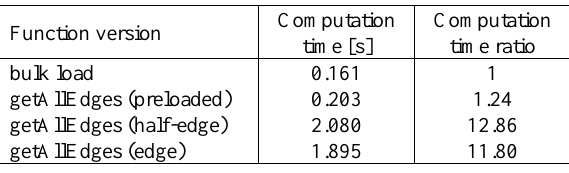
Table 4. Loading time of the building model.